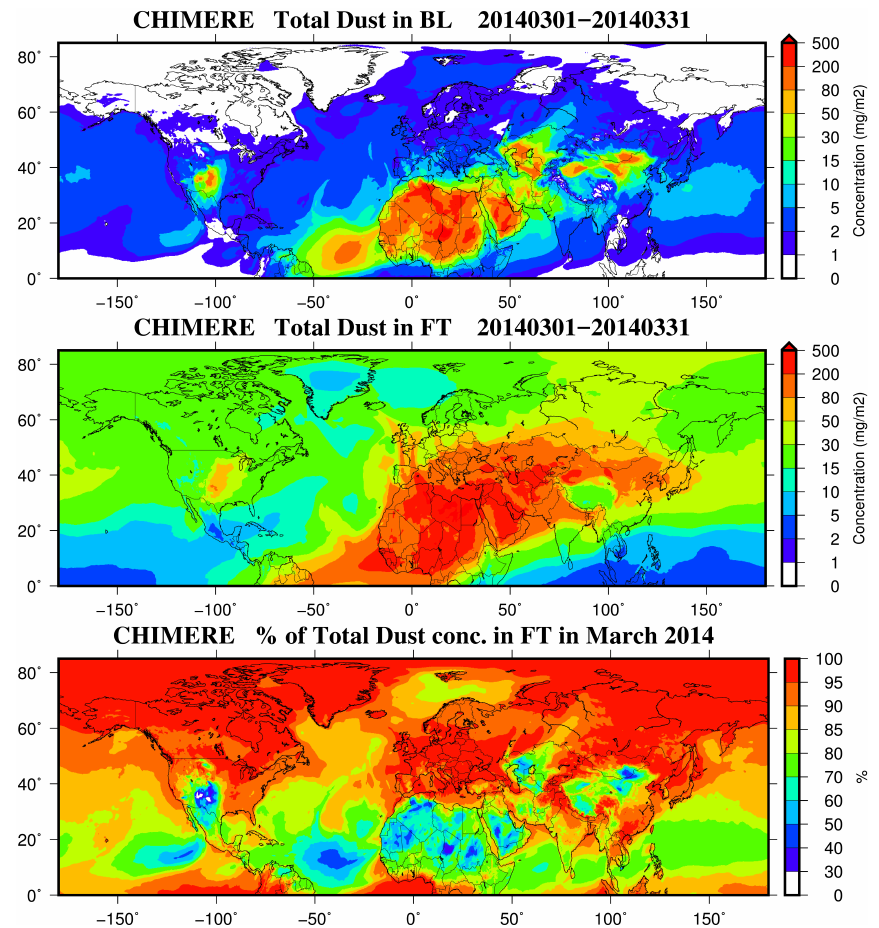
Figure 8. Averaged monthly mean concentration of total dust integrated over: the Boundary Layer ( top ); and above in the Free Troposphere in mg m − 2 ( middle ); and ratio in percent of the FT concentrations versus the total column (BL + FT) as defined in Equations (3) and (4) ( bottom